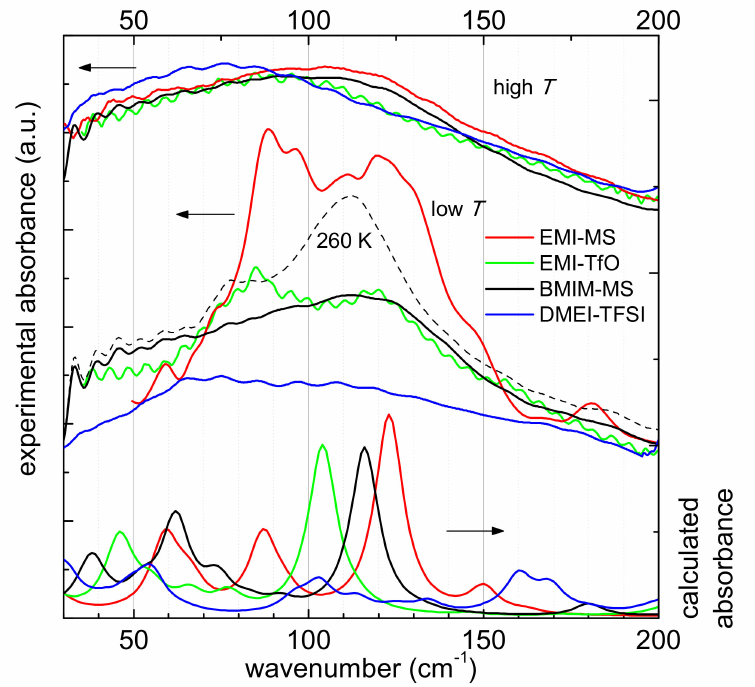
Figure 7. Far infrared experimental spectra of the samples DMEI-TFSI (blue lines), EMI-TfO (green lines), EMI-MS (red lines) and BMIM-MS (purple lines) measured at the highest temperature (top) and at 160 K (middle). For BMIM-MS the spectrum measured at 260 K is also shown (black dash line). The calculated spectra for all four ionic couples are presented in the bottom part of the